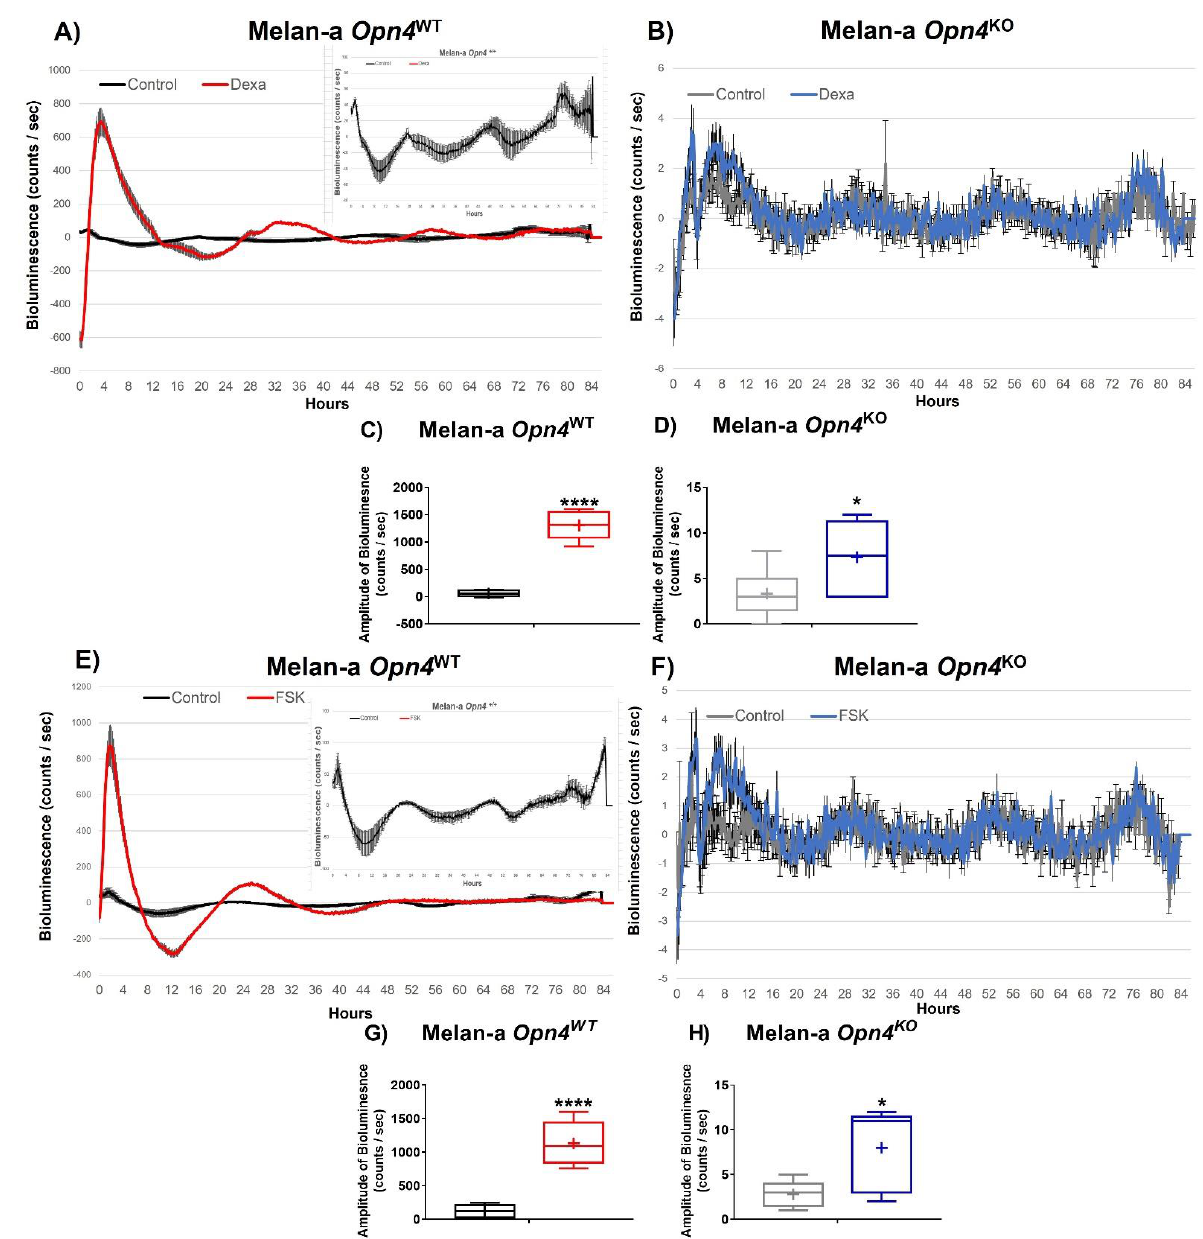
Figure 3. Per1 :Luc bioluminescence of Opn4 WT and Opn4 KO melanocytes treated with dexamethasone ( A – D ) or forskolin ( E – H ). ( A , B , E , F ) Representative graphs of bioluminescence. Inserts represent the untreated control groups in a different scale; ( C , D , G , H ) amplitude of bioluminescence. ( n = 5–6). * p < 0.05; **** p < 0.0001.